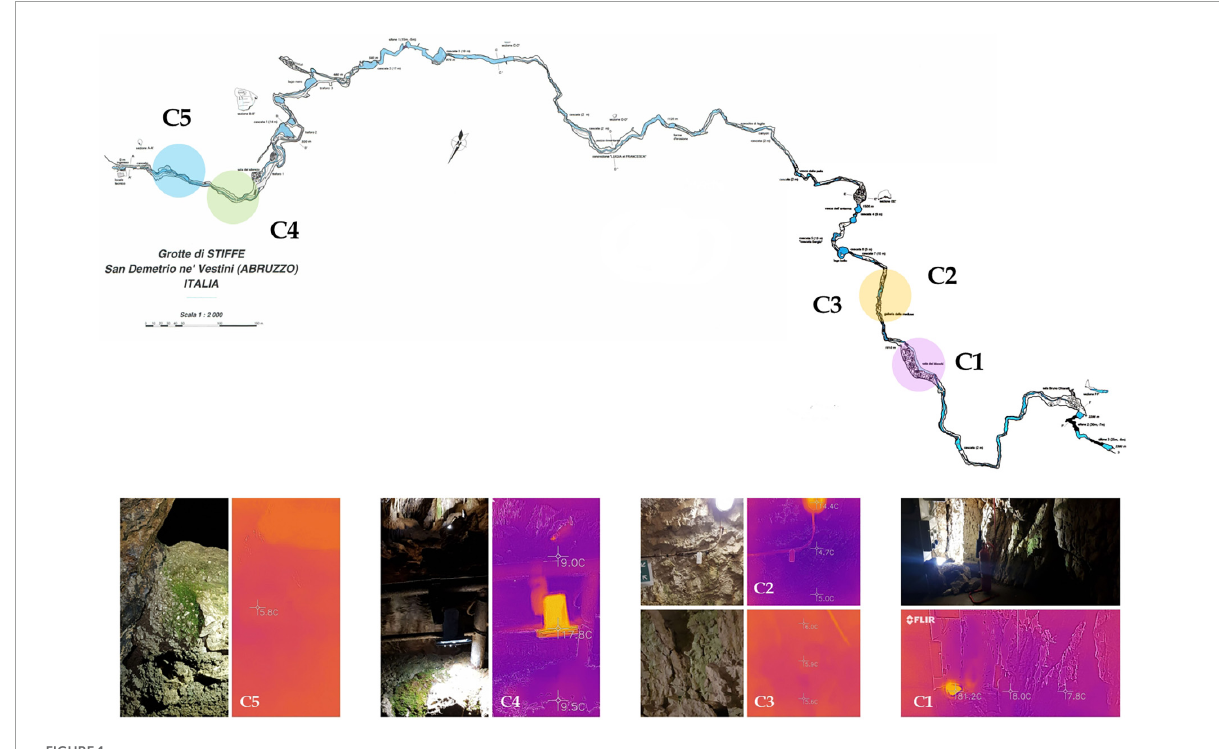
FIGURE1 Cave survey of the “Stiffe” caves. Sampling areas are highlighted in the plan view and pictures on the bottom show the thermic camera and normal photos for each site.